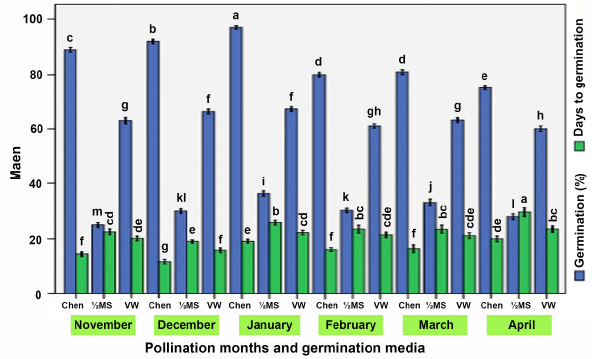
Fig. 3. Influence of pollination time and media on asymbiotic seed germination frequency (%) and speed of germination Data signify (mean±standard error bar) 5 flowers per treatment in 10 replicated experiments. Mean column with the same letter are not significant at P ≤ 0.05 based on one-way analysis of variance (ANOVA) followed by Tukey’s test. Data expressed as percentage were transformed using arcsine prior to ANOVA and converted back to the original scale for demonstration in the histobar (Compton,